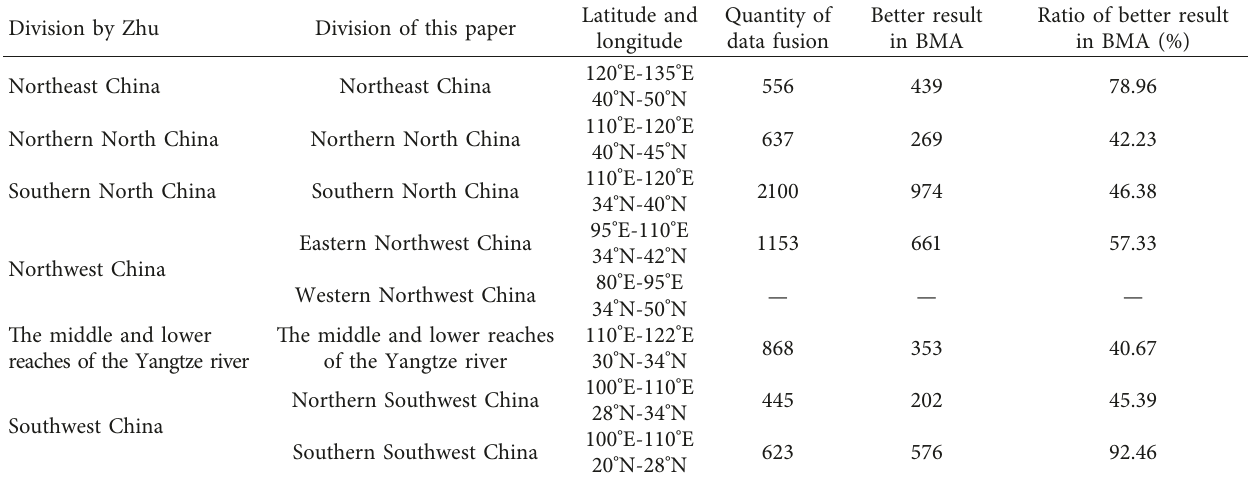
Table 1: Comparison of regional divisions and fusion